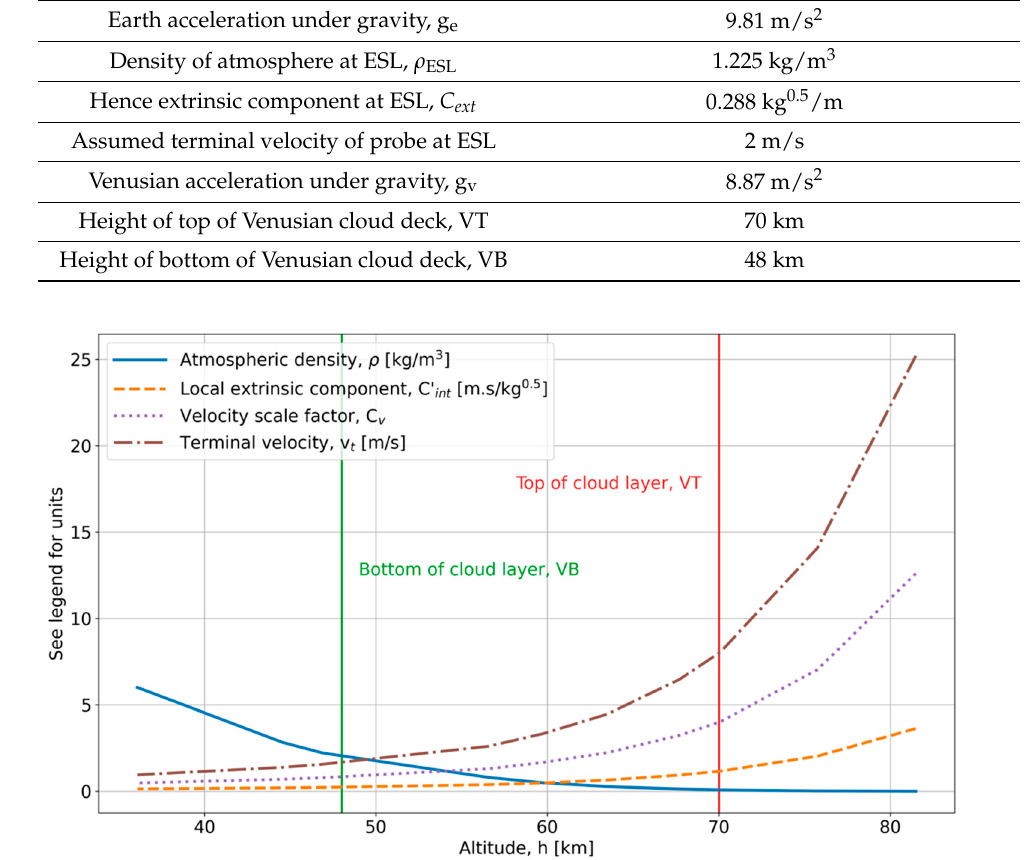
Figure 23. Intermediate outputs from extrapolation model.